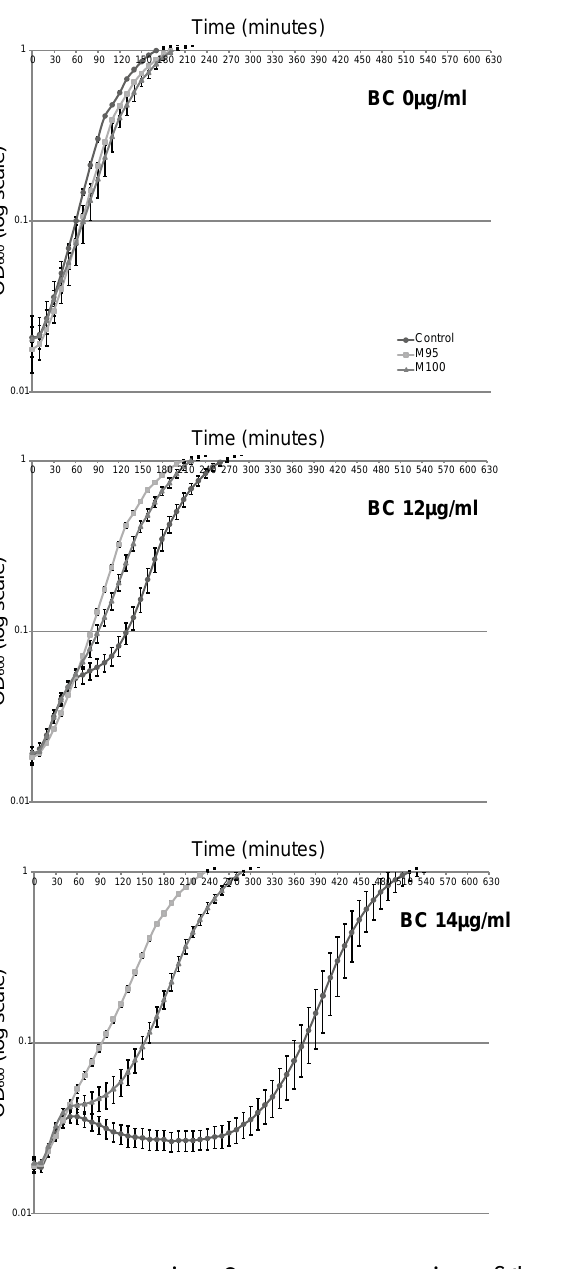
Genome sequencing: Genome sequencing of the control and the two BC selected isolates (M95 and M100) revealed three single point mutations (in the control, M95 and M100), compared to the reference genome ( E. coli U00096 ), leading to an amino acid substitution, in genes kdpD , hcp and one single point mutation in a non-coding region. A single point mutation in gene rpsA (nucleotide